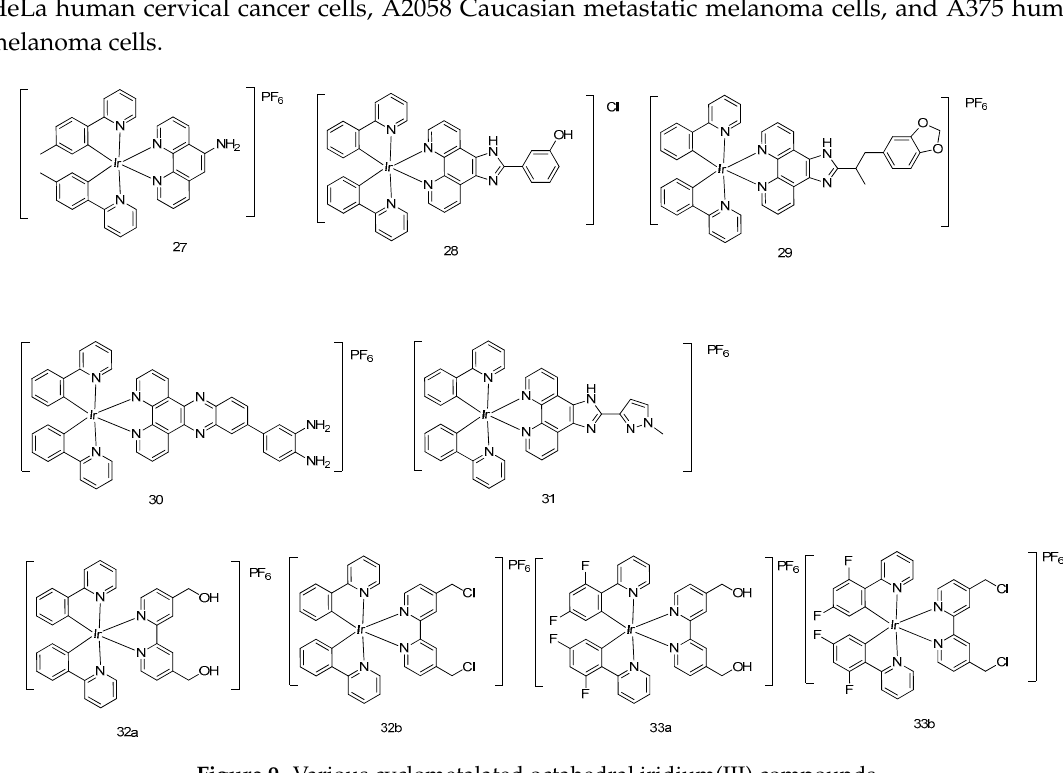
Figure 10. Cyclometalated octahedral iridium(III) compounds with 1-phenyl-pyridine C^N ligand and different N^N ligands. An iridium complex 37 (Figure 11) was devised by Meggers and coworkers as a phototoxic anticancer agent [49]. Upon irradiation by visible light, the cellular survival of HeLa cells was reduced